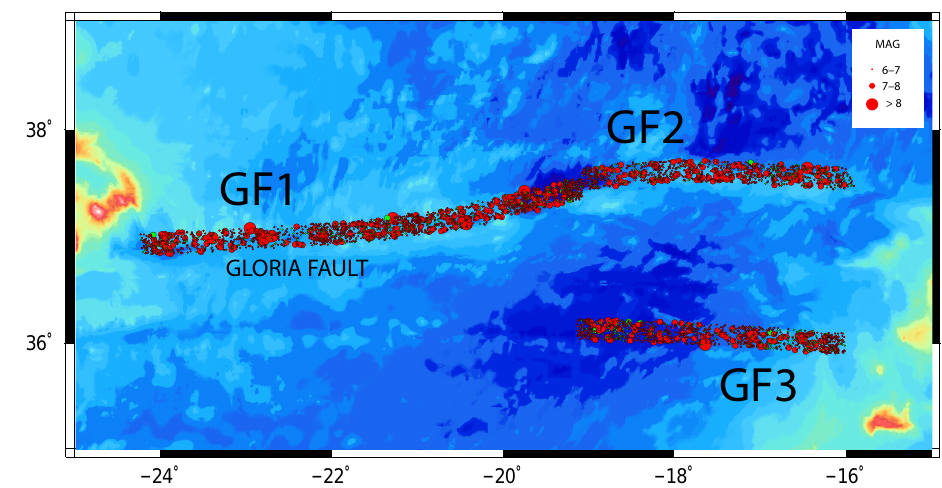
Figure 2. Decomposition of Gloria Fault into three main segments: GF1, GF2, and GF3. The red dots correspond to the epicentre distribution as given by the seismic catalogue. Green circles correspond to deep earthquakes (depth greater than 30km). Table 1. Summary of the main seismotectonic parameters related to the two largest events occurred during instrumental times in the Gloria Fault area. Event µ M w L W